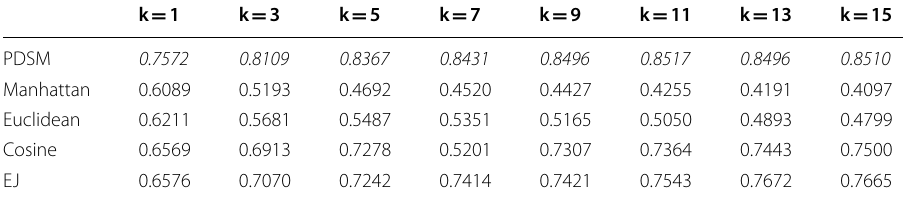
Table 7 k NN classification AC (WebKB, tf-idf)